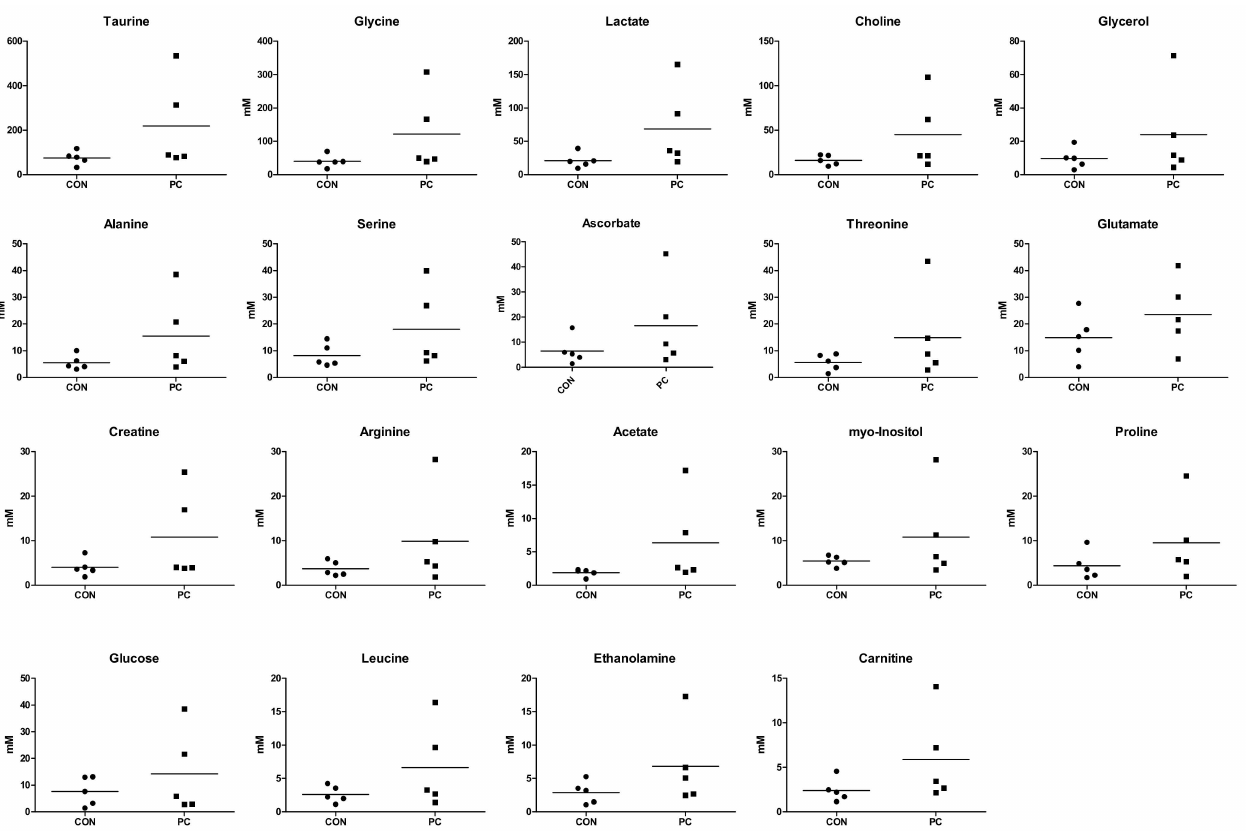
Figure 6. Concentrations of endogenous metabolites in lung samples of mice. Major lung metabolites (variable importance plot (VIP) ≥ 0.5), t -test and Unpaired t -test were performed to assess statistical significance compared with control (CON) and positive control (PC); • , CON; (cid:4) ,